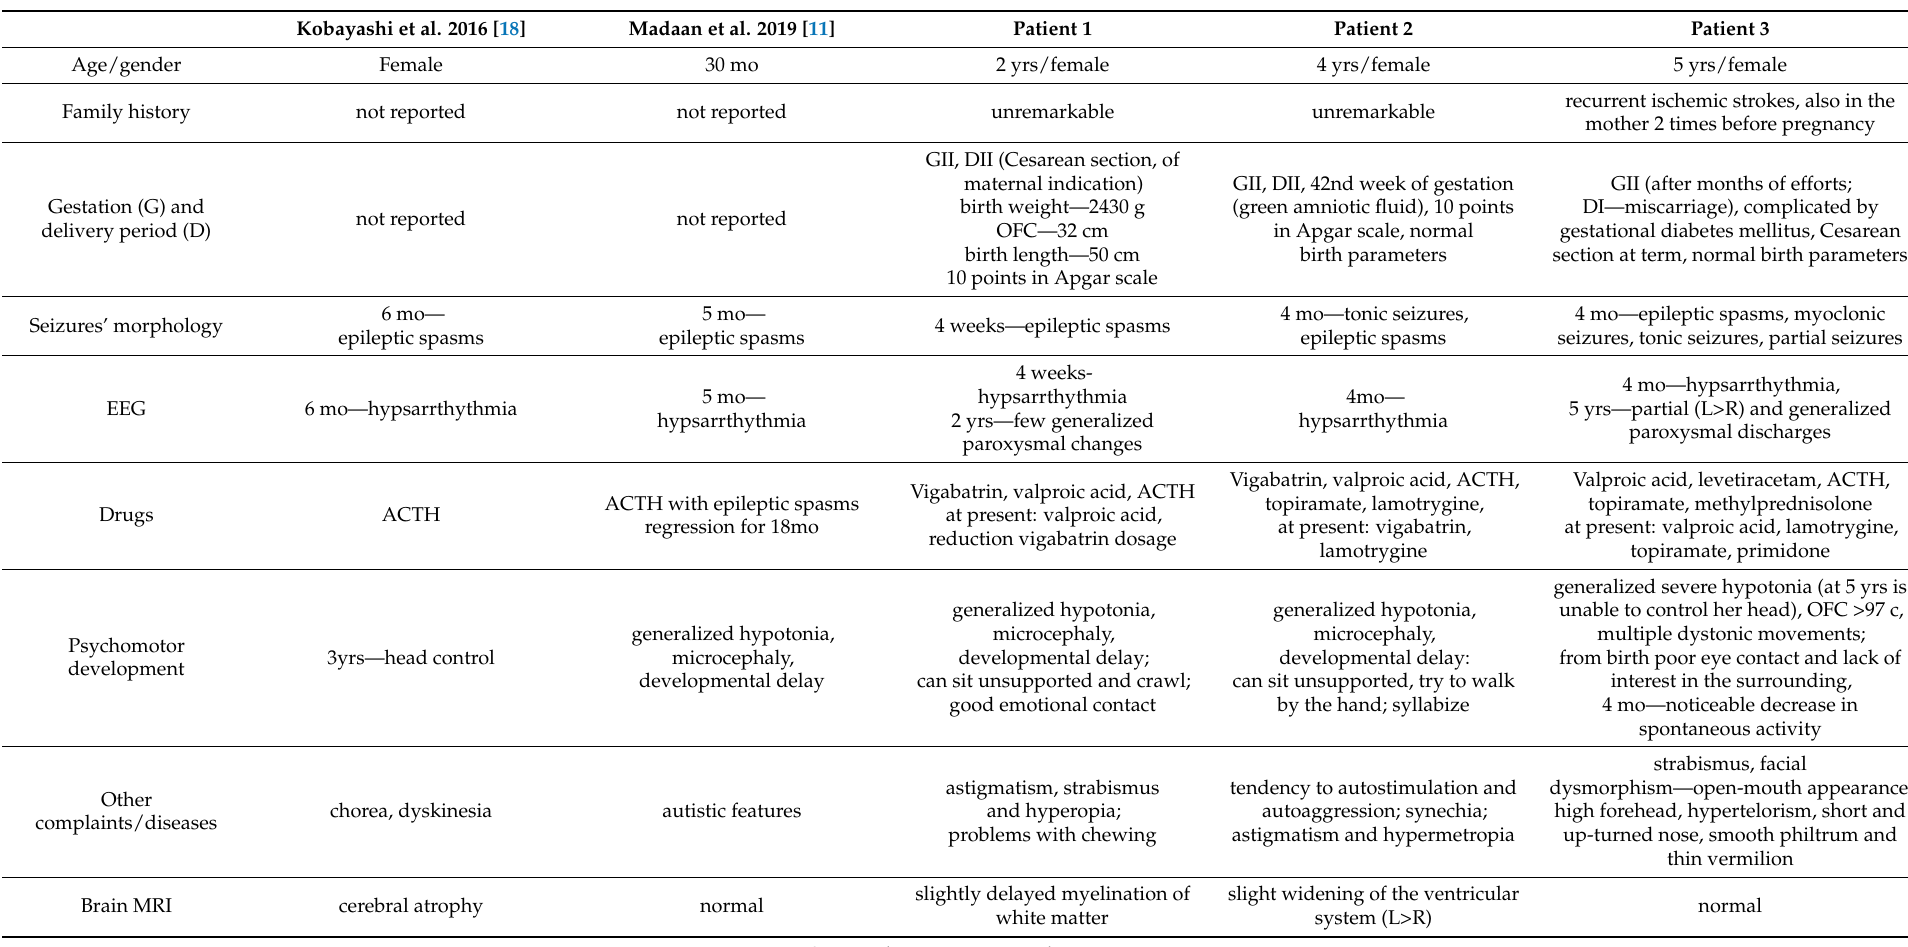
Table 3. Neurodevelopmental histories of ALG13-CDG patients with c.320A>G variant who did respond to the antiepileptic treatment [11,18] and those diagnosed by us as ALG13